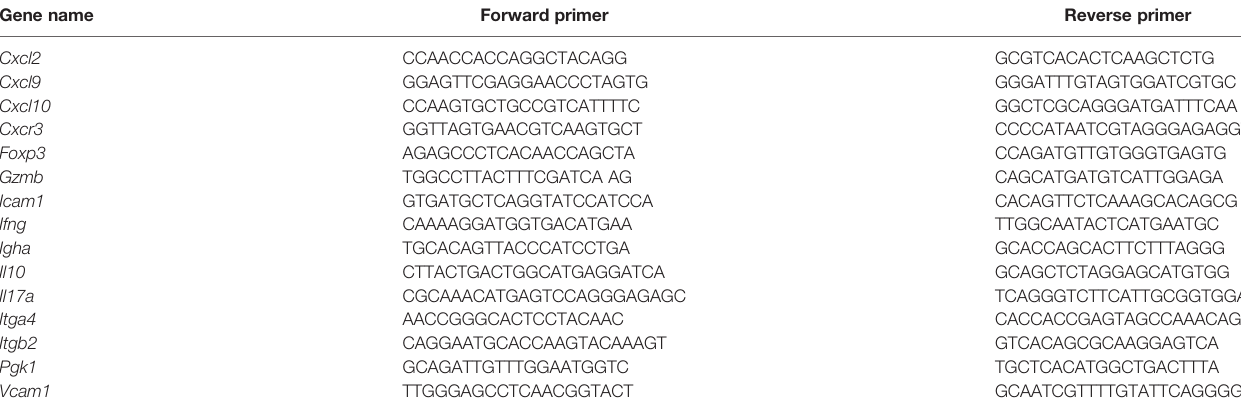
TABLE 1 | The primer sets for real-time polymerase chain